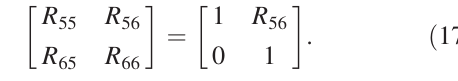
transmission, without a buncher. C2 performs very well, since it was optimized for vertical focusing only, and C3 shows a small improvement.